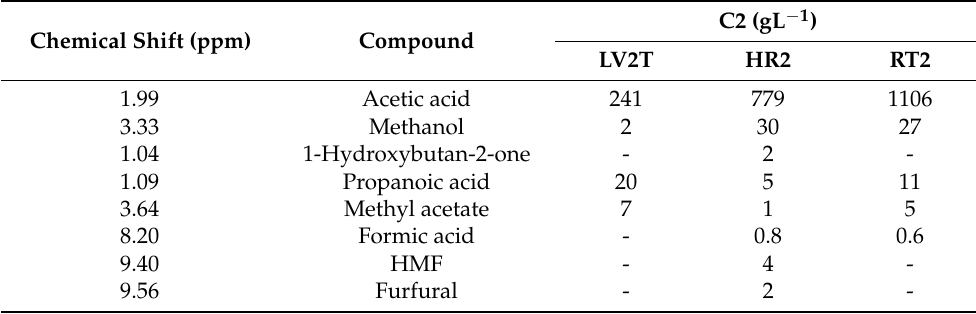
Table 3. Concentration of identified compounds in hemp distillates of leaves, hurds, and roots at a condensation temperature of 70 ◦ C by 1 H